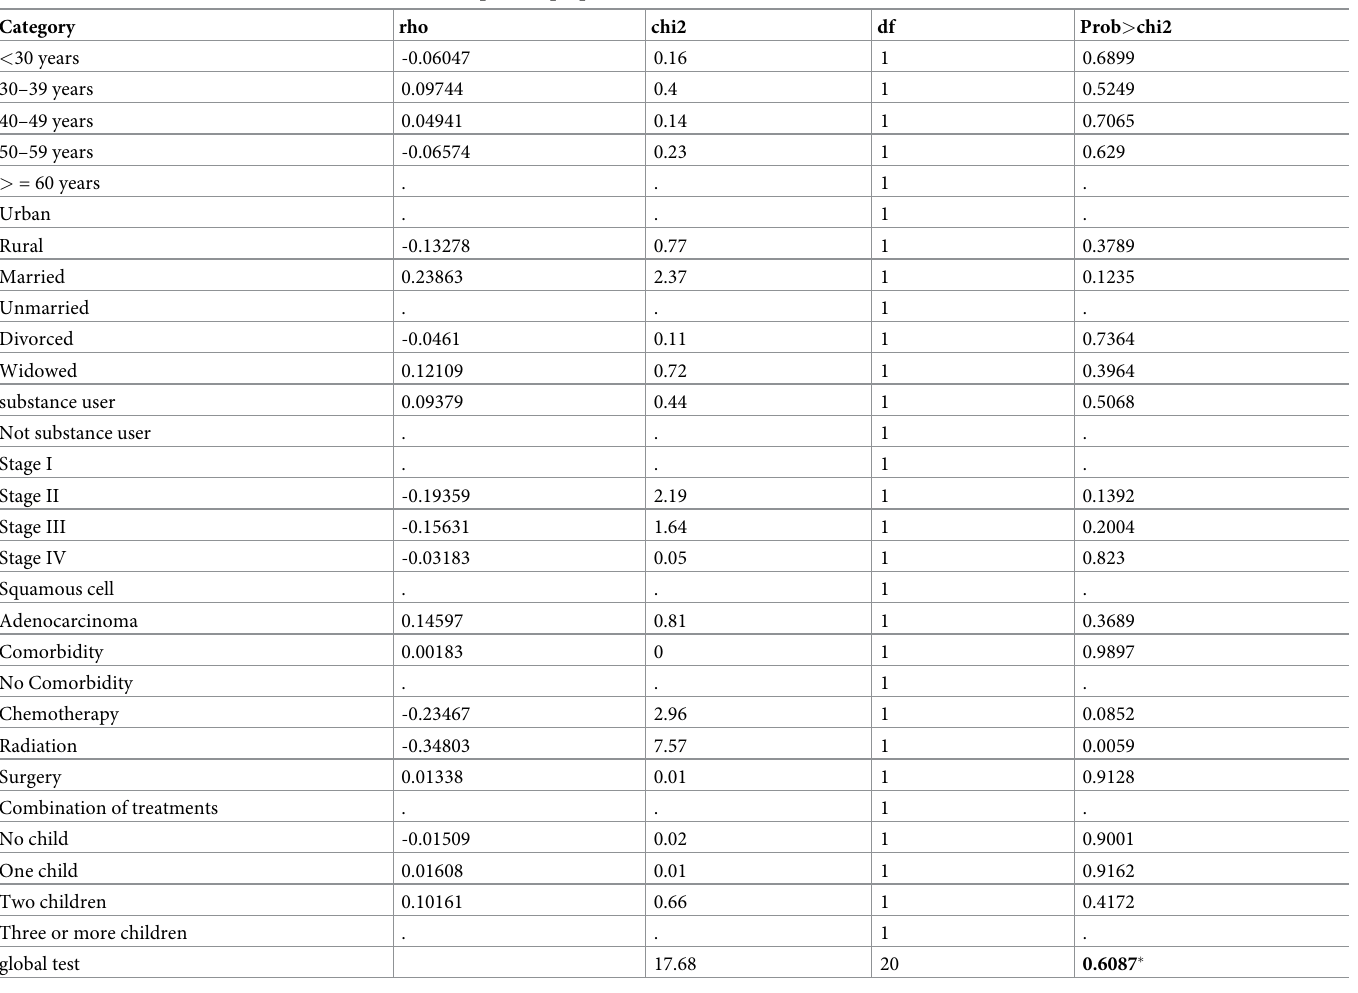
Table 6. Table Schoenfeld residual test to check the assumption of proportional